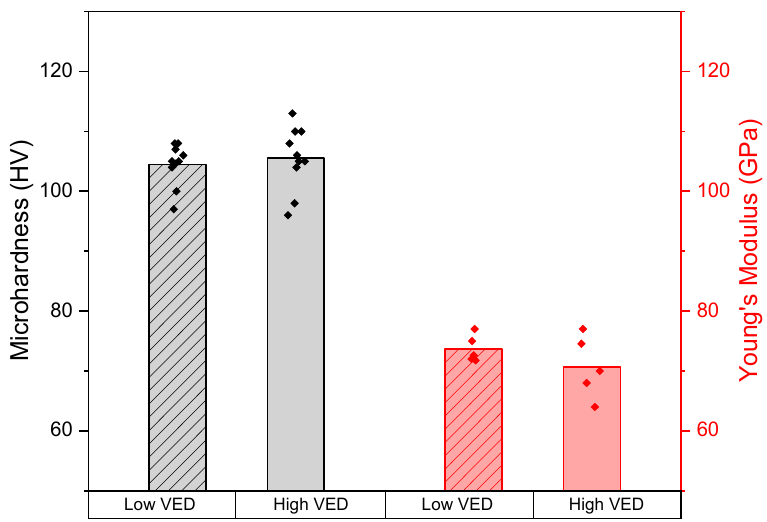
Figure 6. Results of microhardness and Young’s modulus tests for low- and high-VED as-built sam- ples.